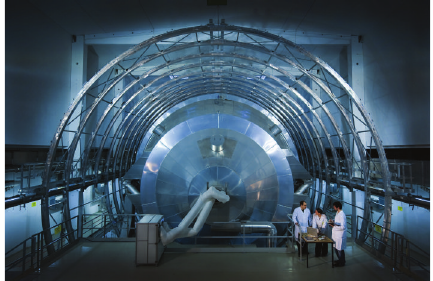
Figure 21: Photograph of air coil system surrounds the main spec- trometervessel.Itspurposeistocompensatetheearthmagneticfield and to fine-tune the magnetic field inside the main spectrometer.